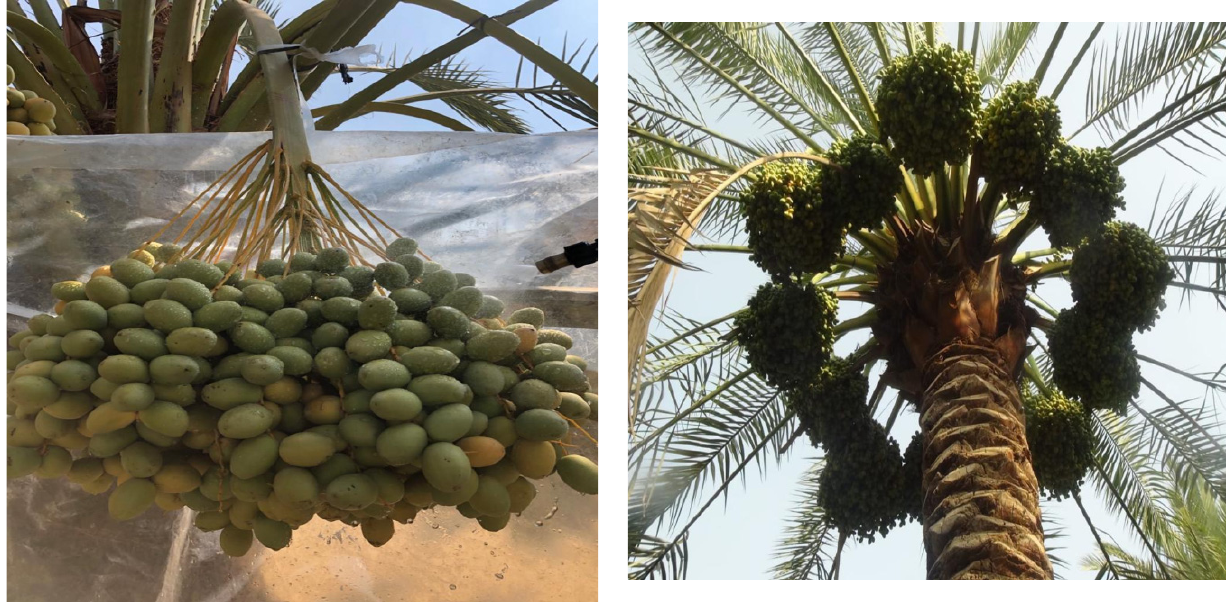
Figure 2. Barhi date palm fruits during the foliar spray application of some pre-harvest treatments.